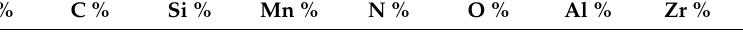
Table 1. Chemical composition of OT4-1 alloy.